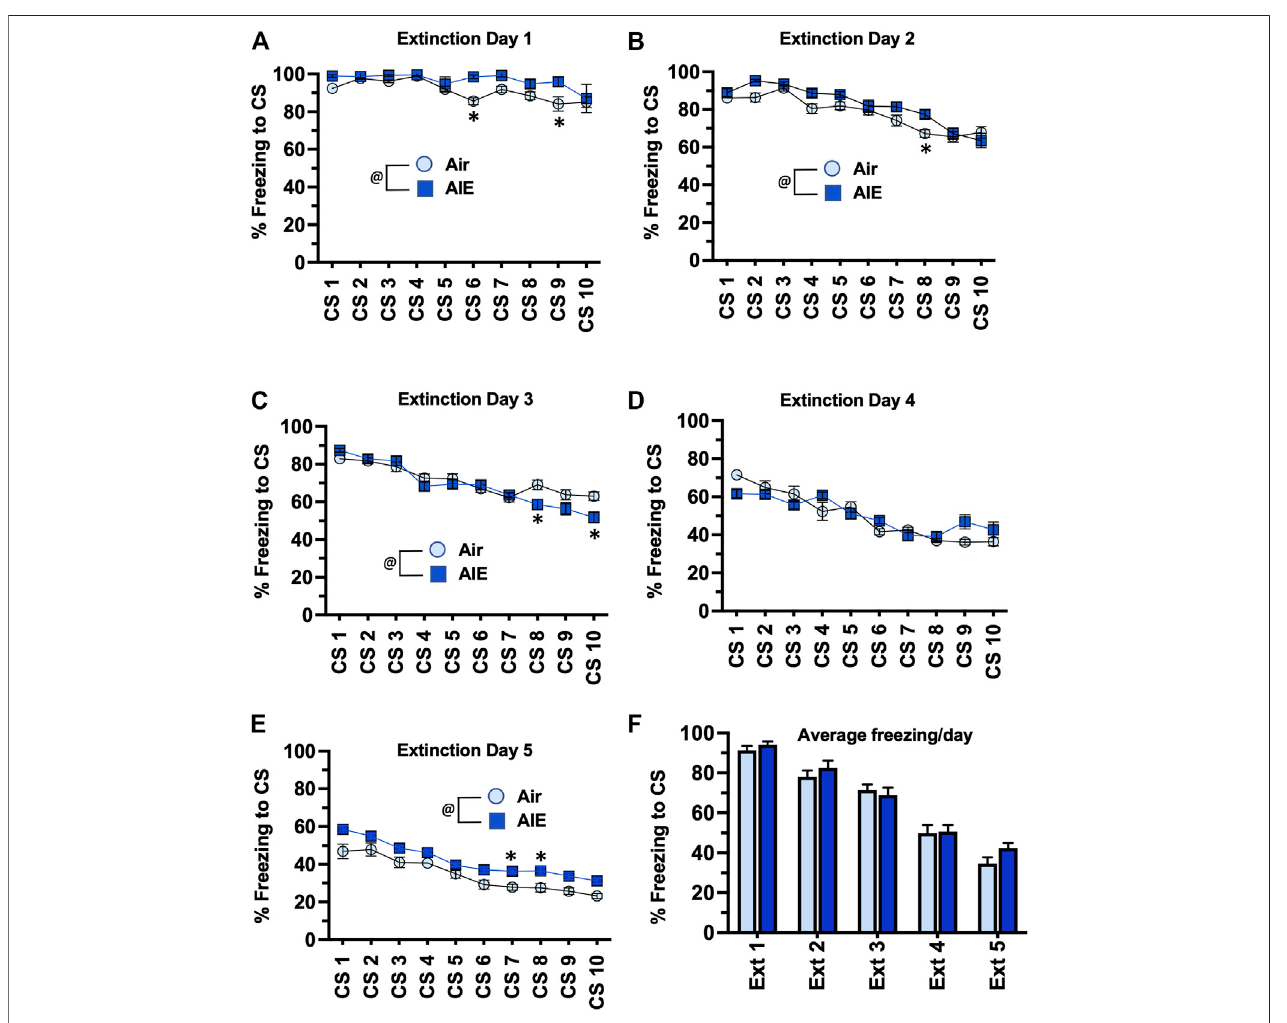
FIGURE3 | AIE exposuredid not alter extinction ofconditioned fear inadult male rats. (A – E) Five consecutive days ofpresentation ofthe conditioned tonewithout the shock (10/session/day) resulted in a day and session-dependent reduction of freezing to the conditioned stimulus. There were small but statistically signi fi cant different increases and decreases in the levels of freezing in the AIE versus Air control rats that depended upon the particular day of extinction. However, comparison of theaveragefreezingacrossthe10tonesforeachdailyextinctionsession (F) revealedtherewerenosigni fi cantdifferencesbetweentheAircontrolandAIEexposed rats at any of the 5 extinction days. @, signi fi cant group difference of Air versus AIE (all p values < 0.05); * , signi fi cant difference compared to respective CS tone # (all p values < 0.05); n = 14/group.